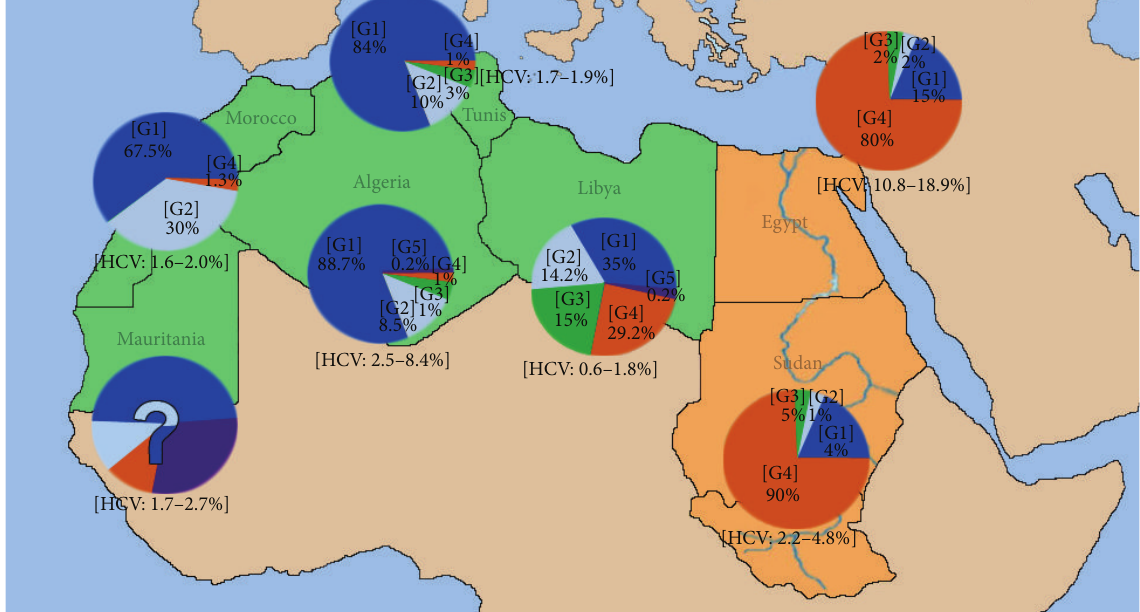
Figure 1: Geographic distribution of HCV genotypes among HCV-infected individuals in North Africa. G1, G2, G3, G4, and G5 refer to the respective genotypes of